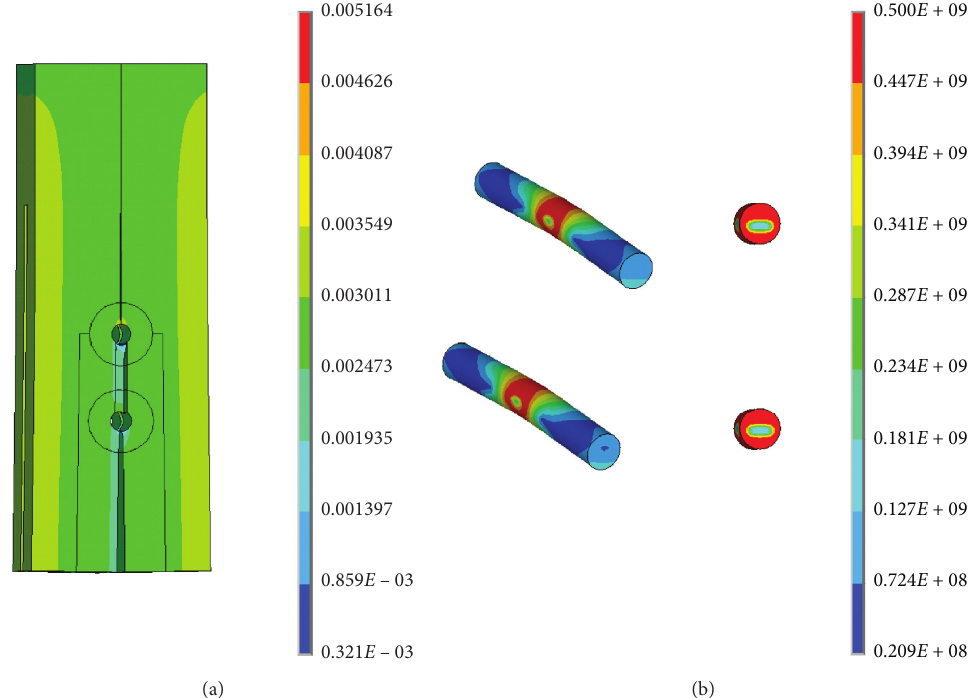
Figure 12: Failure mode of initially perfect Joint 1: (a) splitting failure of wooden parts; (b) von Mises stress distribution of